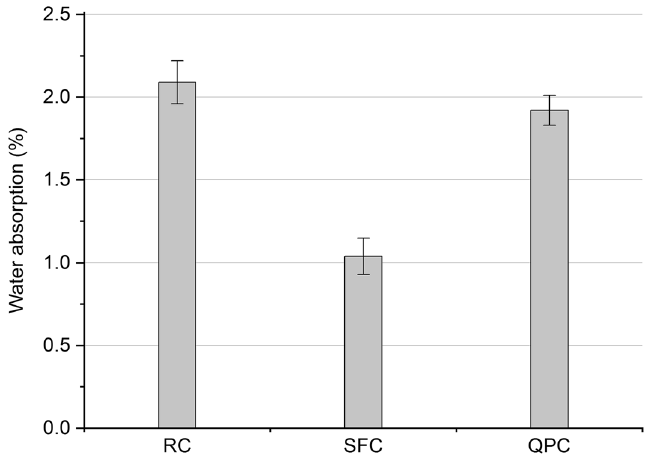
Figure 8. Water absorption by immersion of the RC, SFC and QPC at 28 days of